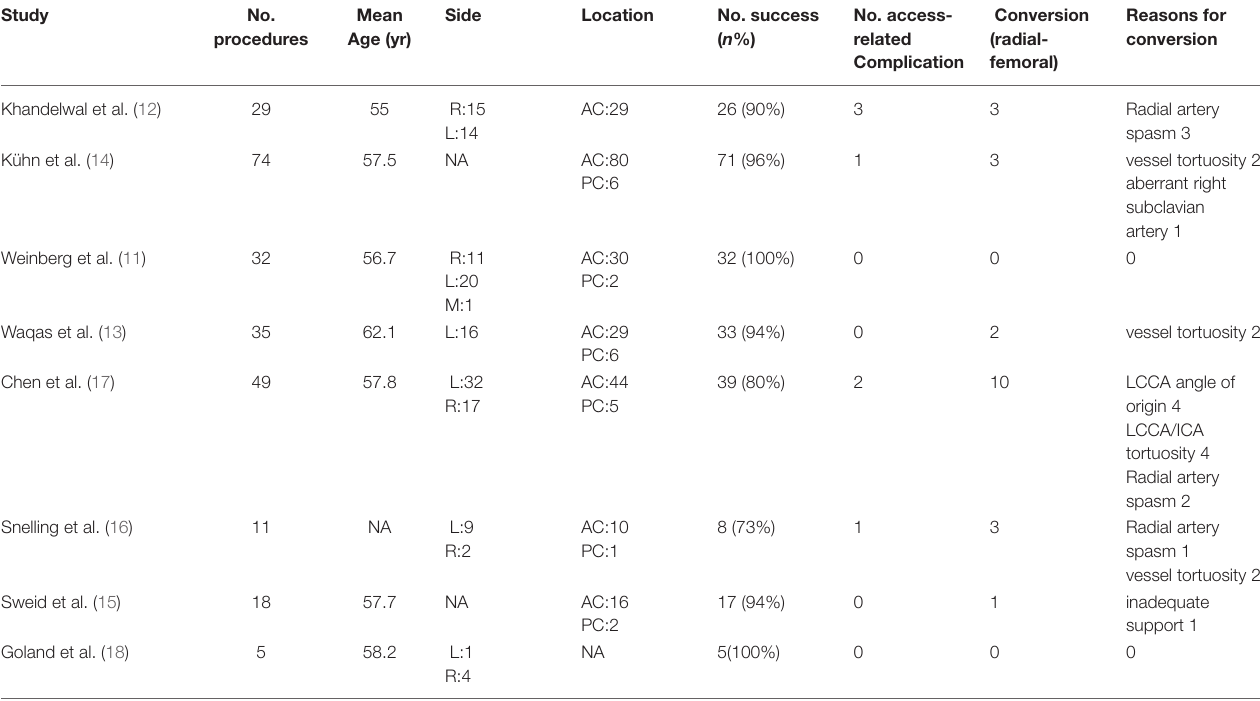
TABLE 1 | Evaluation of the included studies using the criteria described by Murad et al. (10). Study